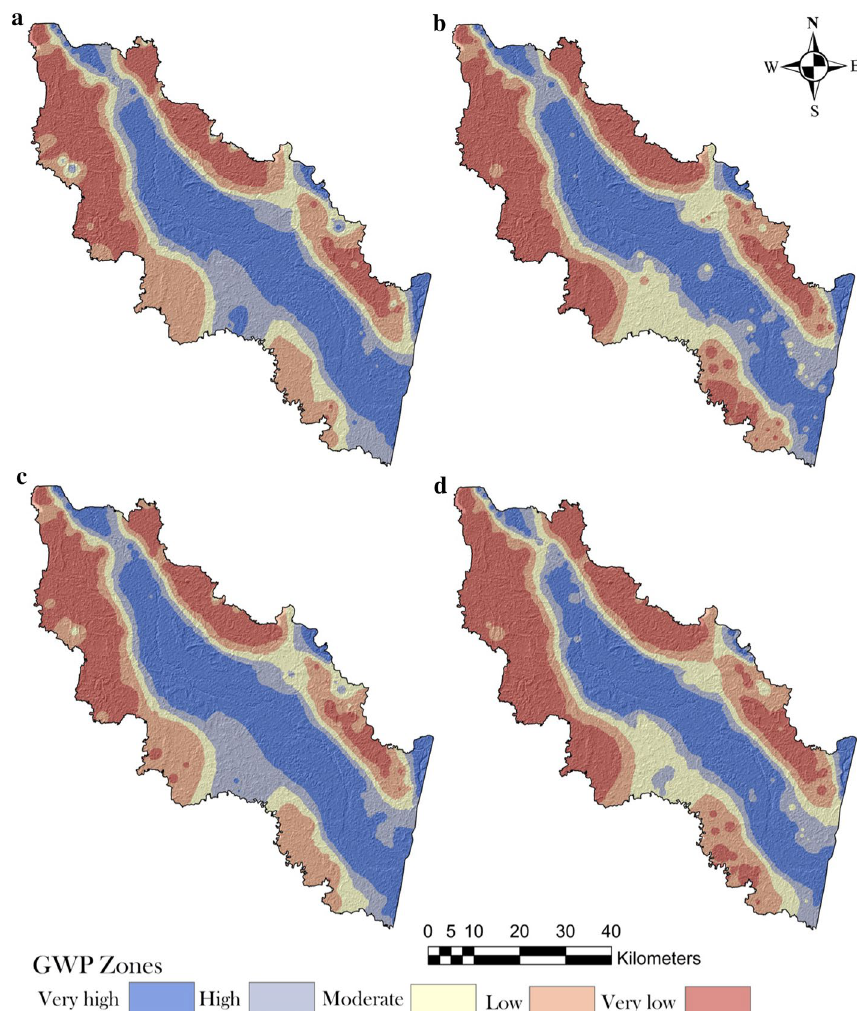
Fig. 9 Novel hybrid models with the integration of EML models and ROC weighted fuzzy operators, a AND, b OR, c GAMMA 0.8, and d GAMMA